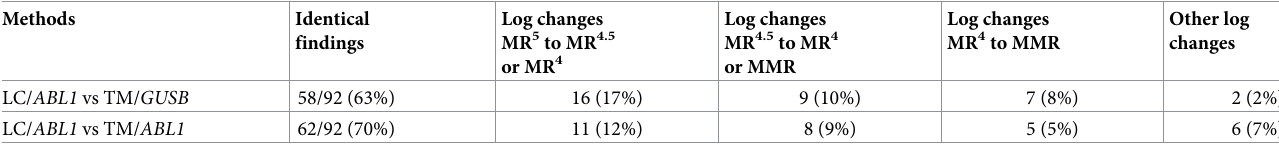
Table 1. TM and LC findings in